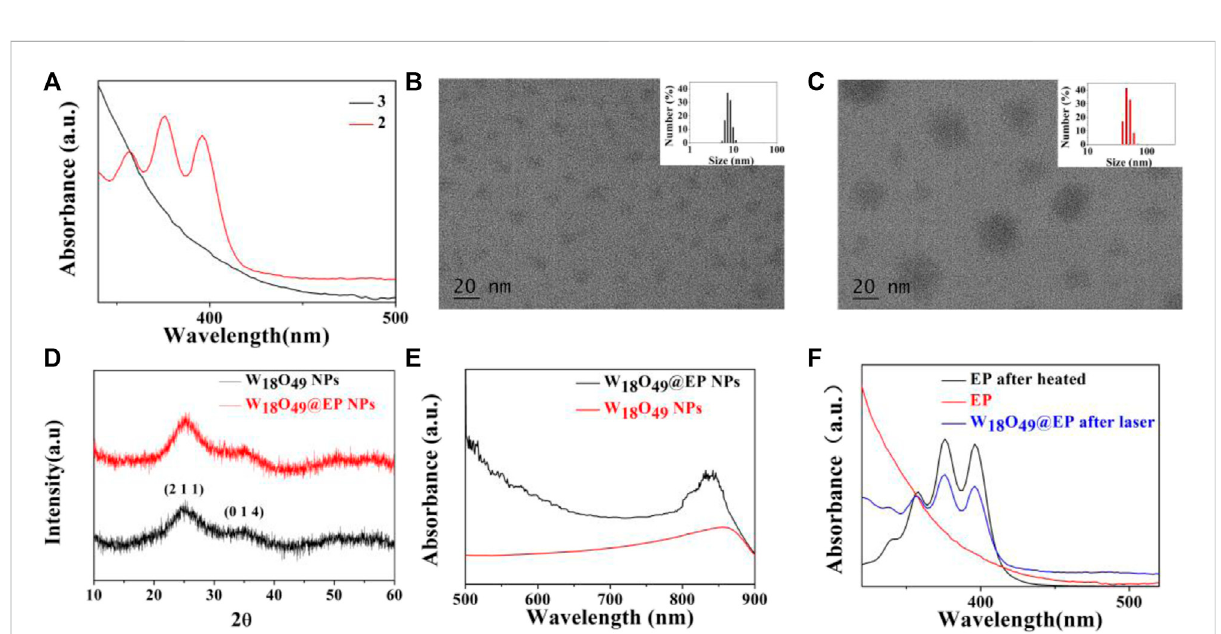
Characterizationofmaterials. (A) UV-Visspectraofcompound2and3. (B) TEMimageofW 18 O 49 NPs,(theupperrightinsertisitsDLSresult). (C)